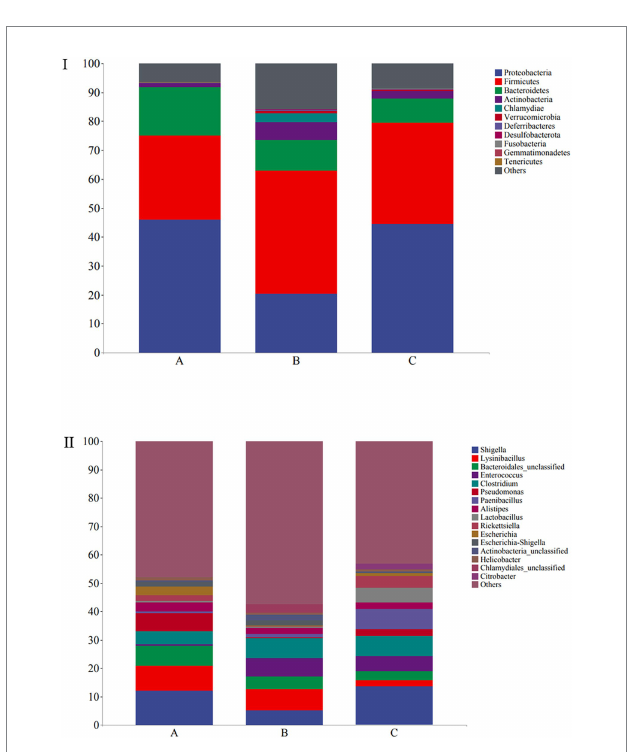
FIGURE 4 Stacked bar plots showing average percentages of the wild Arborophila rufipectus and Lophura nycthemera gut bacteria population compositions at the (I) phyla level and (II) genera